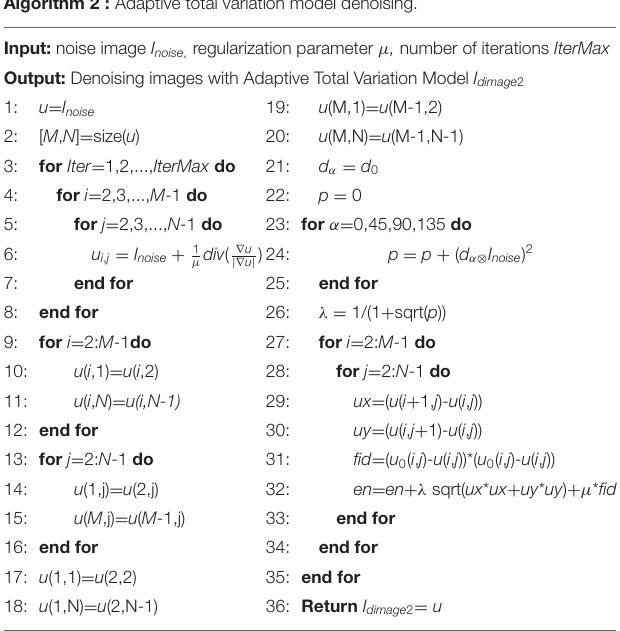
Algorithm 2 : Adaptive total variation model denoising.